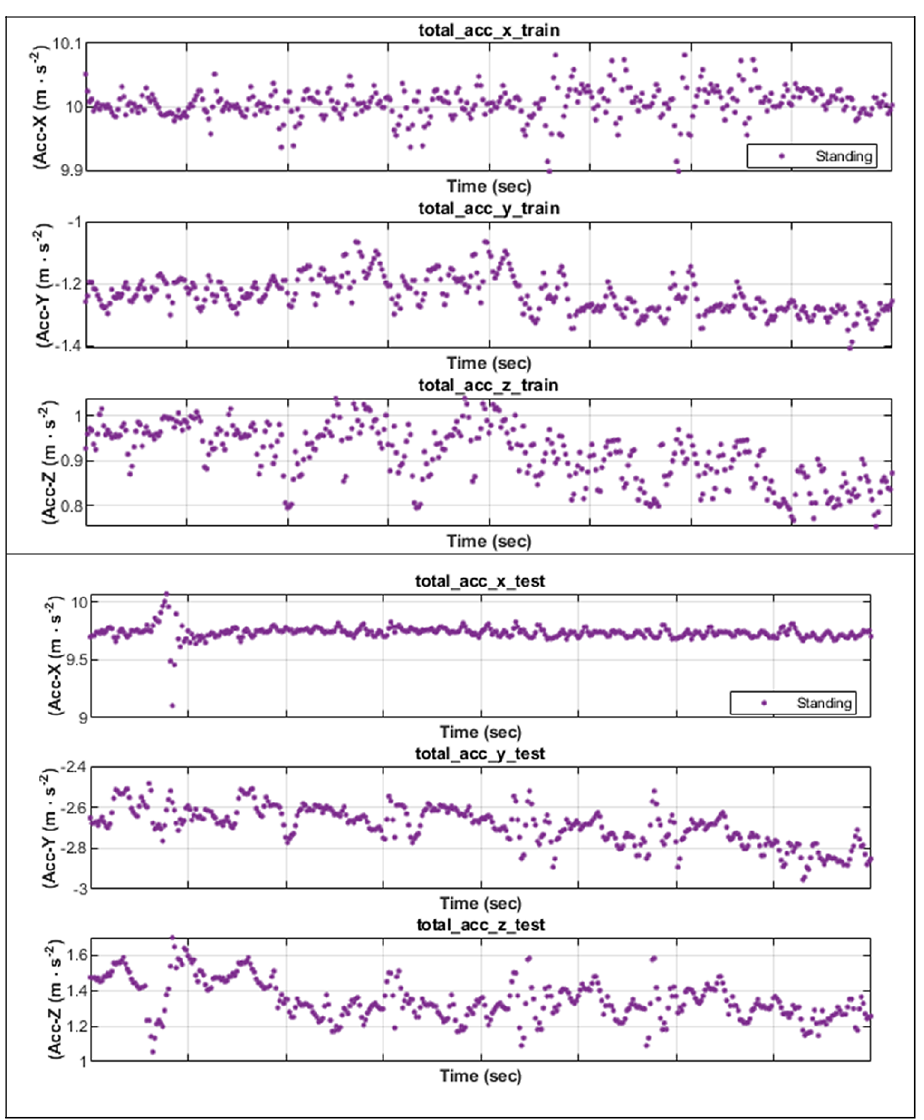
Figure 3. Different inertial data patterns of standing between two subjects.